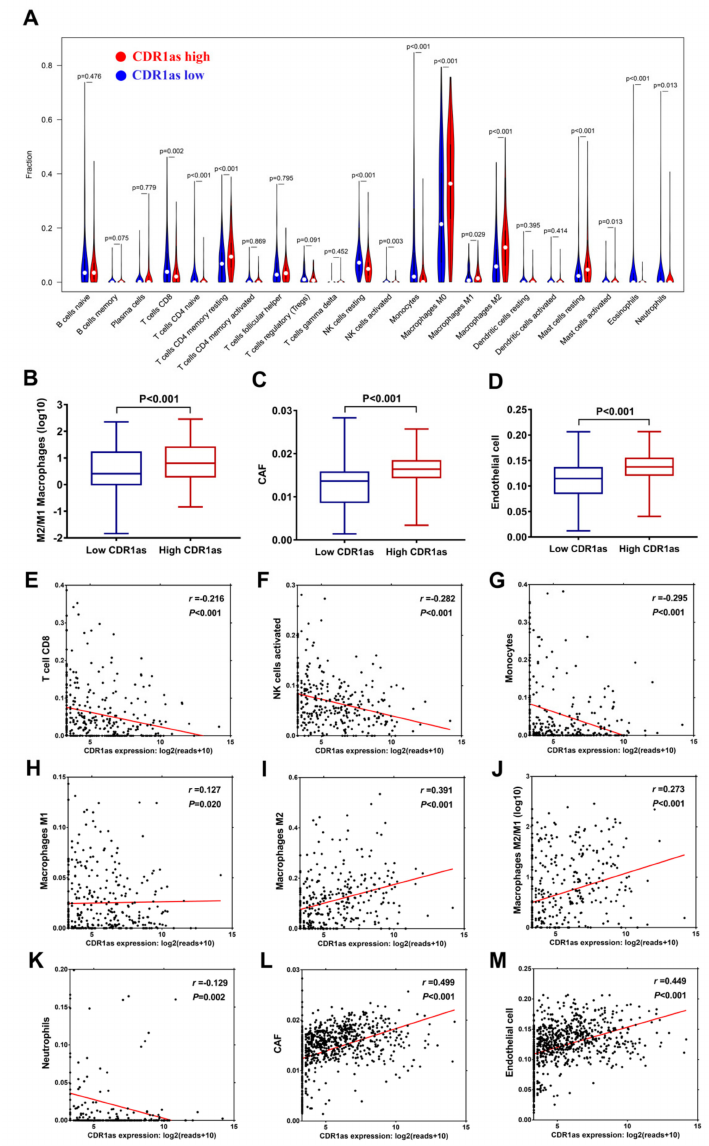
Figure 4. Relationship between cerebellar degeneration-related protein 1 antisense transcript (CDR1as) expression and certain immune and stromal cell infiltration evaluated by CIBERSORT and the EPIC algorithm, respectively. ( A ) Relative density of 22 types of infiltrated immune cell in CDR1as a high and low expression group. ( B ) Ratio of M2 to M1 macrophages in CDR1as a high and low expression group. ( C – D ) Relative density of cancer-associated fibroblasts (CAFs) and endothelial cells in CDR1as high and low expression groups. ( E – H ) Correlation of CDR1as expression with ( E ) CD8 + T cells, ( F ) activated NK cells, ( G ) monocytes, ( H ) M1 macrophages, ( I ) M2 macrophages, ( J ) ratio of M2 to M1 macrophages, ( K ) neutrophils, ( L ) CAFs, and ( M ) endothelial